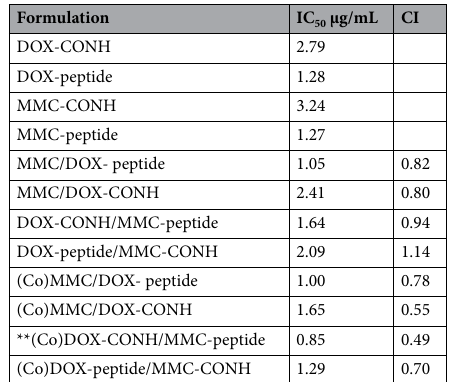
Table 2. IC 50 and CI values of different formulations in drug resistant HepG2cell (**p <0.05).